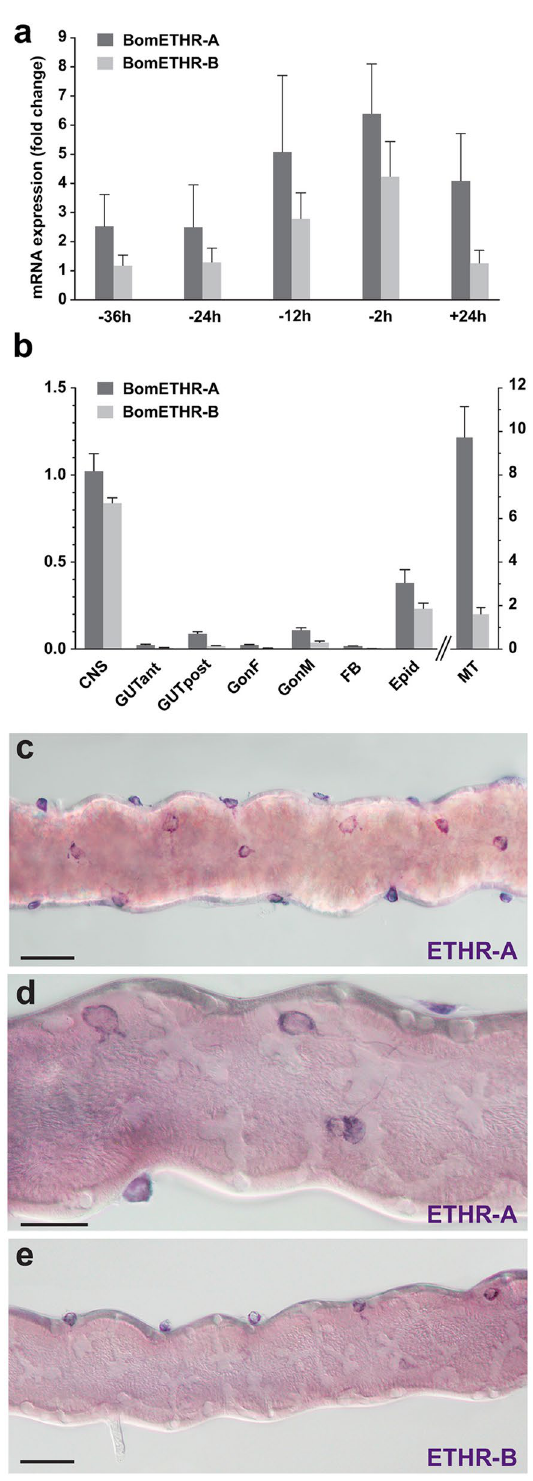
Figure 12. Temporal changes and spatial distribution of ETHRs expression. ( a ) Relative transcripts levels of ETHR-A and ETHR-B in the CNS measured at different time points in pharate or ecdysed 5th instar larvae. 0 h represents ecdysis onset. RNA used for RT-qPCR was extracted from CNS with attached CA and H-organ. ( b ) Expression levels of ETHR-A and ETHR-B in different tissues of pharate 5th instar larvae. Error bars indicate standard error of the mean (n = 3). CNS (central nervous system), GUTant (anterior gut), GUTpost (posterior gut), GonF (female gonads) GonM (male gonads), FB (fat body), Epid (epidermis), MT (Malpighian tubules). ( c–e ) ETHR-A and ETHR-B expression in MT cells attached to surface of the Malpighian tubules. Scale bars c, e = 50 µm, d = 25